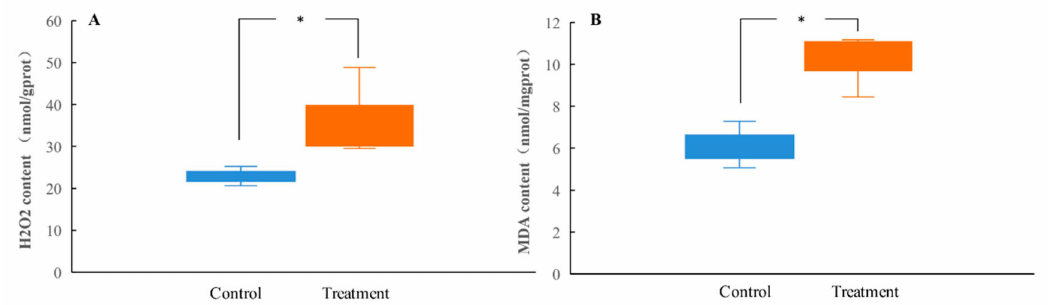
Figure 2. Effect of tannic acid on the H 2 O 2 ( A ) and MDA ( B ) content in the H. cunea larvae at the 6th instar. Asterisk indicates significant differences between control/treatment groups ( n = 3; independent samples t -test; *, p <